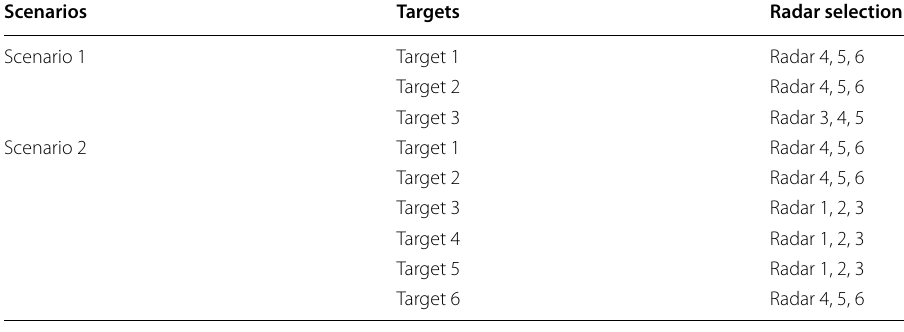
Table 3 The optimal radar selection scheme